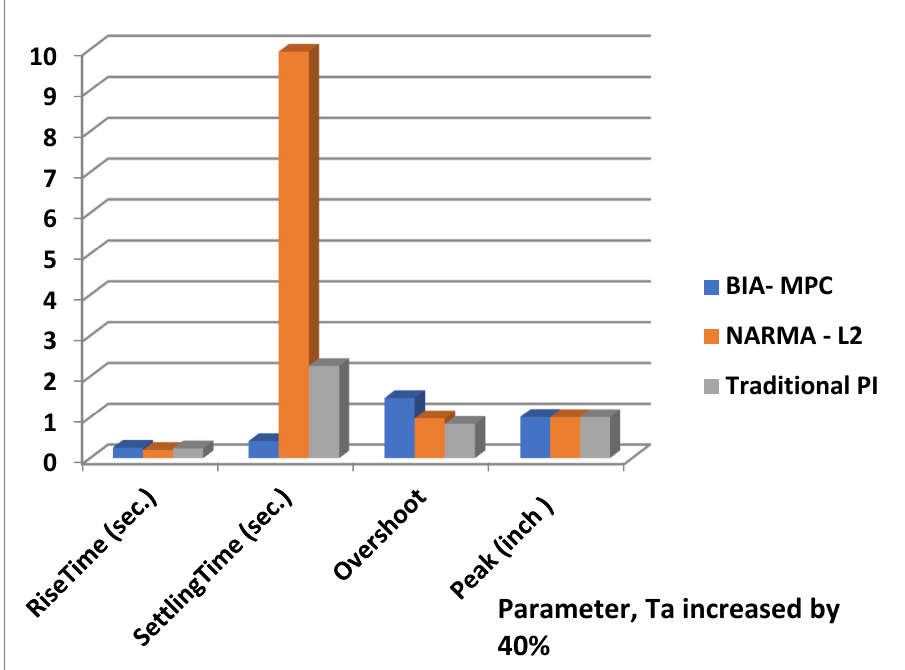
Figure 20. Chart of performance criteria in system perturbation by 30%.